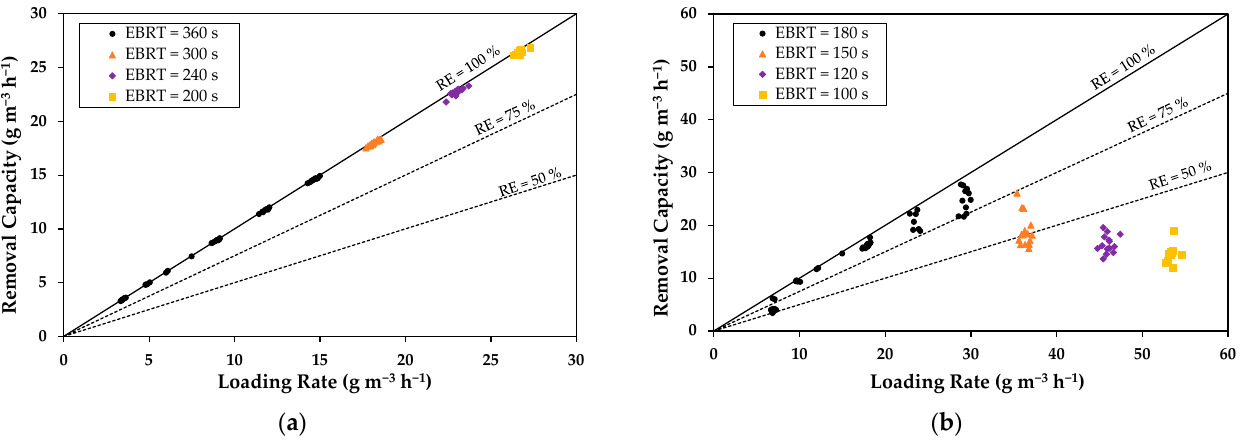
Figure 4. RC vs. LR: ( a ) two-stage process (LR and RC calculated using both the abiotic filter bed and the biotrickling filter bed); ( b ) abiotic filter only (EBRT, LR and RC calculated using the abiotic filter bed volume